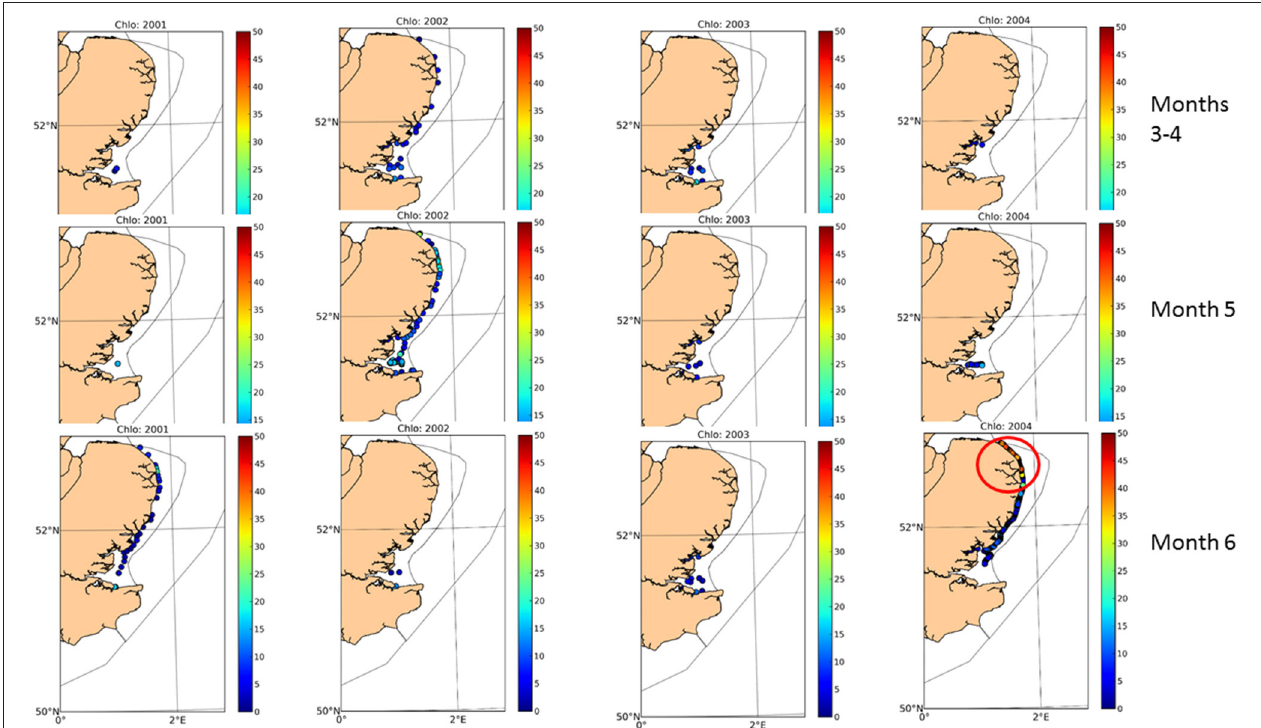
FIGURE 9 | Spatial distribution of chlorophyll observations in time for different assessment years. The red circle shows where the strongest bloom was captured in June 2004.